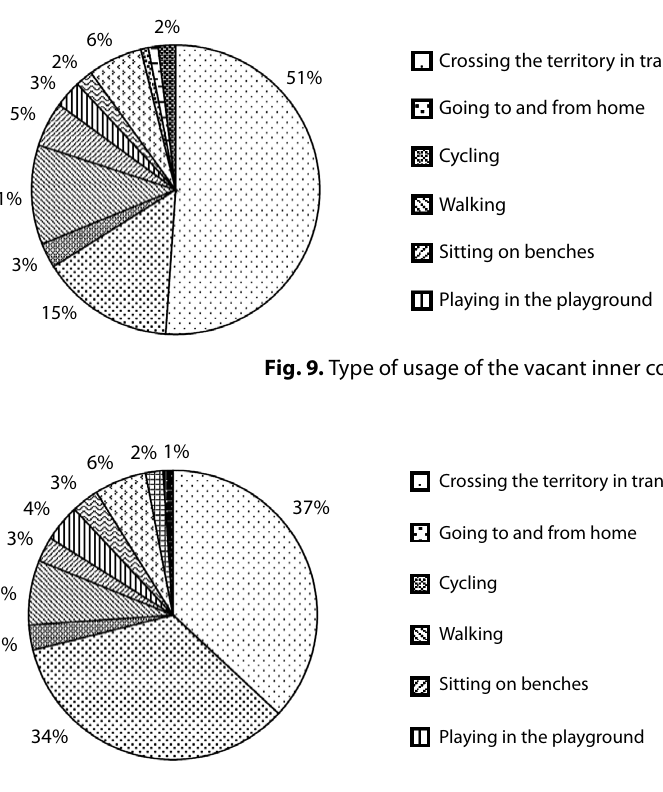
Fig. 10. Type of usage of the built-up inner